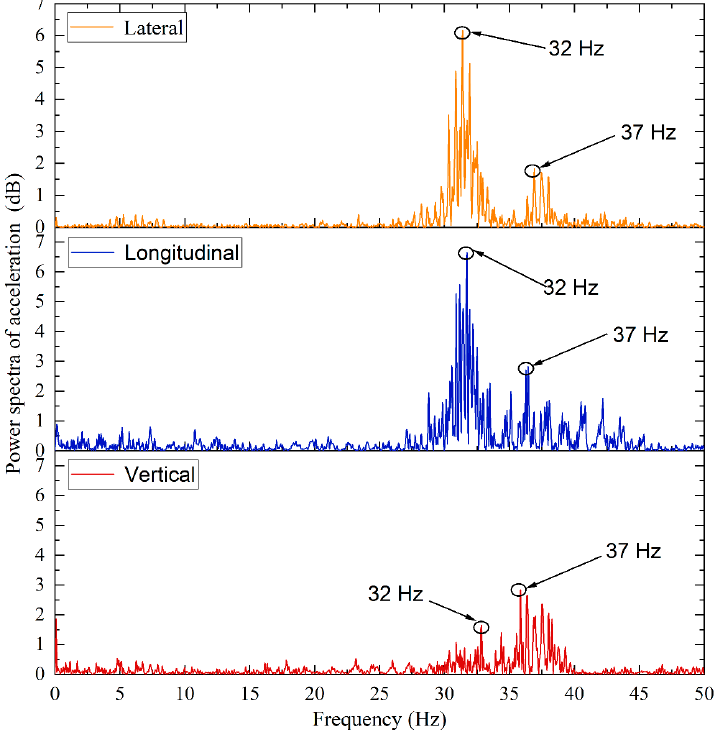
Figure 13. The calculated power spectra of 3D acceleration responses recorded by #R1 during tamping operation.